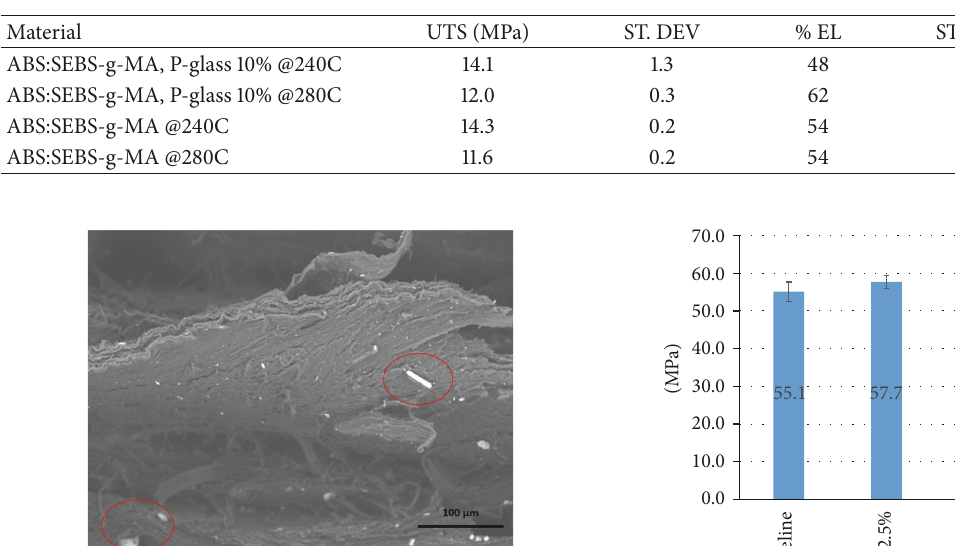
Figure 14: SEM micrograph of the fracture surface of a specimen of ABS:SEBS-g-MA loaded with P-glass at 10% by weight printed at 240 ∘ C.